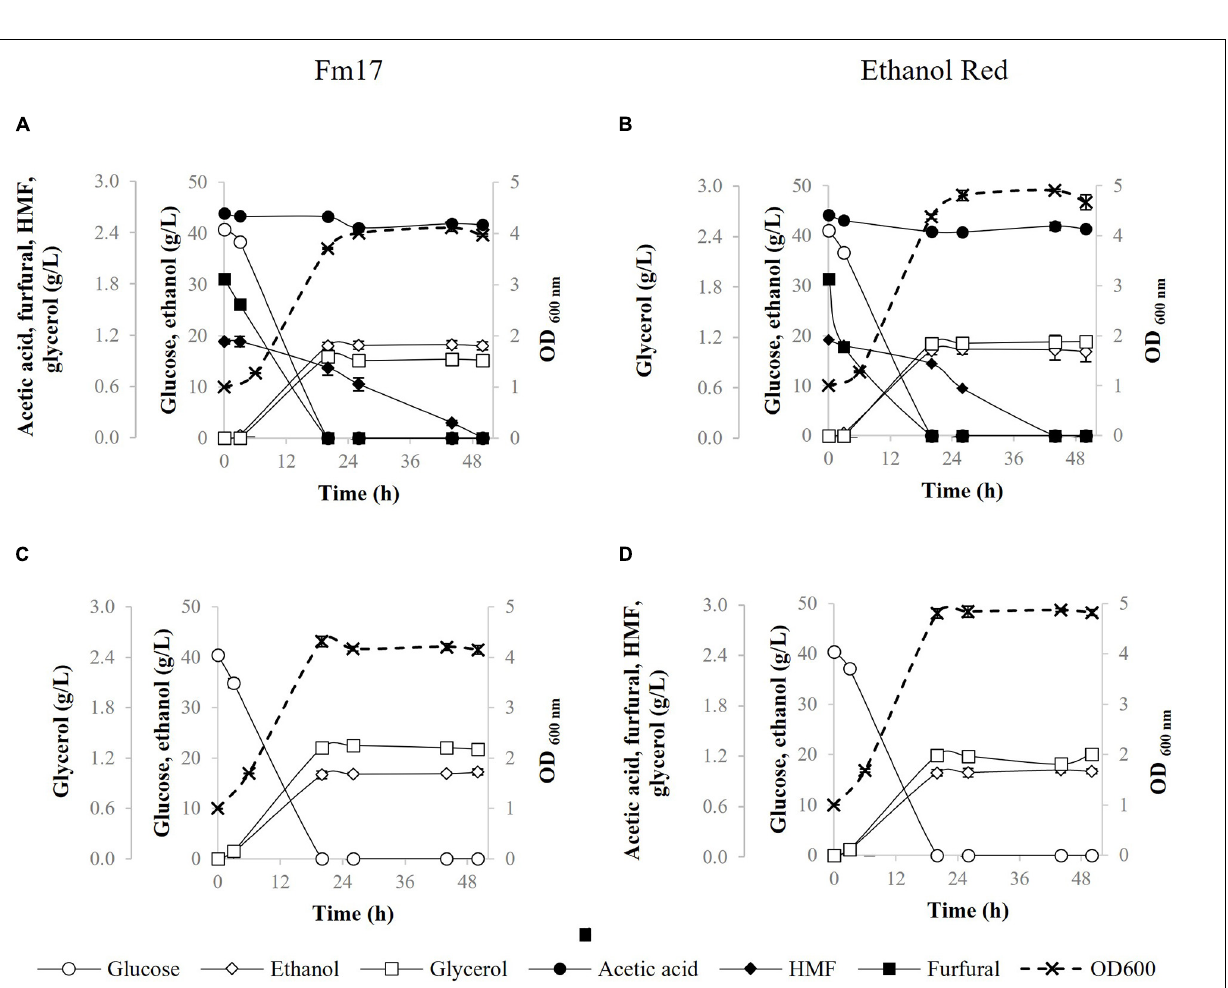
FIGURE 2 | Fermentation performances of Saccharomyces cerevisiae strains in YNB broth containing 40 g/L of glucose with or without addition of pre-hydrolysate Cc3 from Cynara. cardunculus : Fm17 ( A : supplemented with Cc3, C : reference broth not supplemented with Cc3) and Ethanol Red ( B : supplemented with Cc3, D : reference broth not supplemented with Cc3). The acidity of the medium was adjusted to pH 5.0 with NaOH. The experiment was conducted in triplicate. Error bars correspond to the standard deviation of the